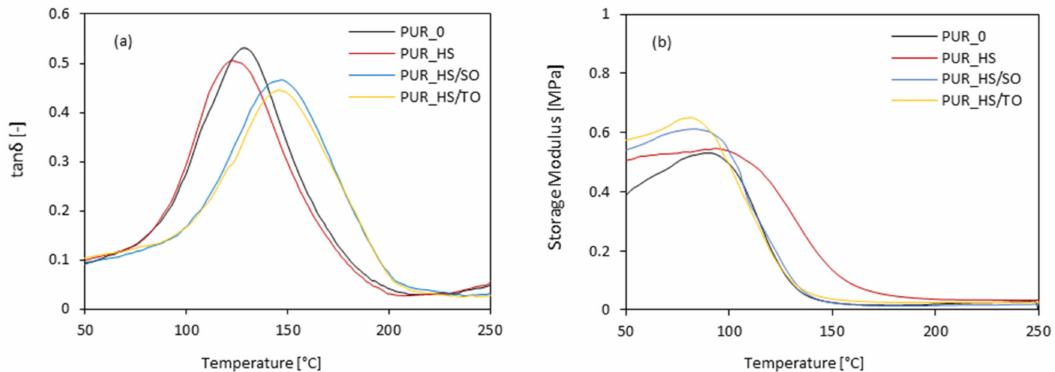
Figure 8. The dynamic–mechanical properties of PUR foams containing HS fillers: ( a )—tan δ and ( b )—storage modulus results.